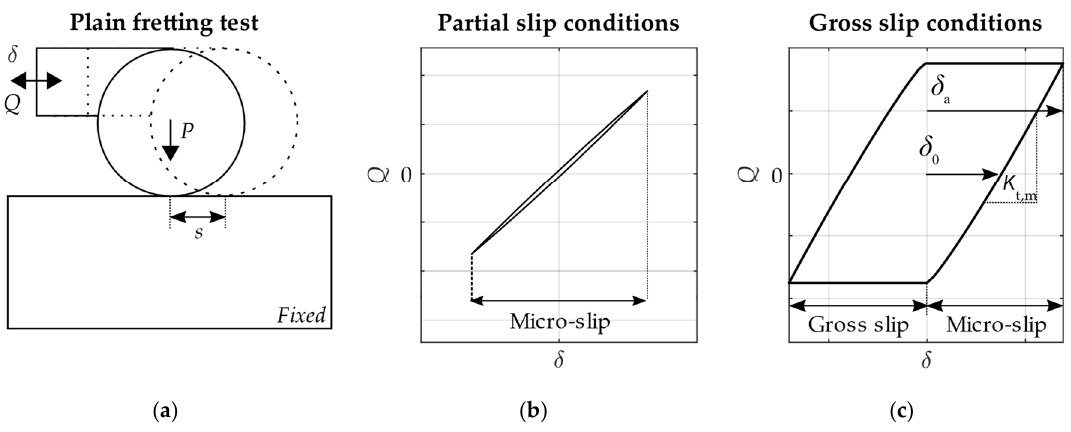
Figure 1. ( a ) Sketch of a plain fretting test; Schematic representation of frictional hysteresis loops obtained in a plain fretting test between elastic bodies with a cylinder to flat contact configuration using an Amontons-Coulomb friction model under ( b ) partial slip conditions and ( c ) gross slip conditions.